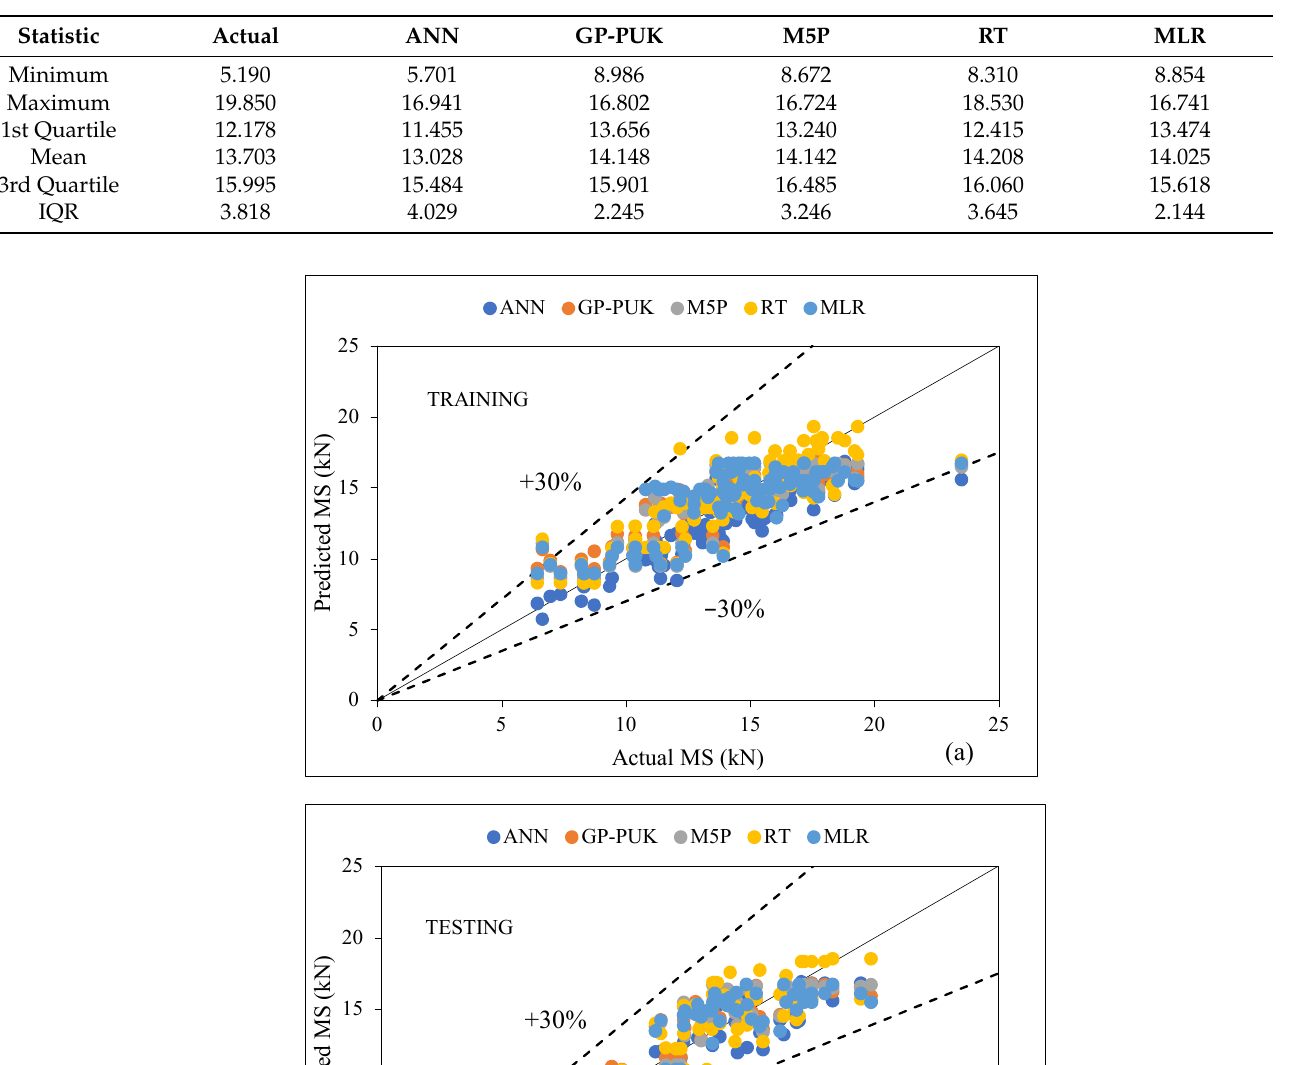
Table 13. Quartile values using actual and predicted values of all applicable models for the test- ing stage.